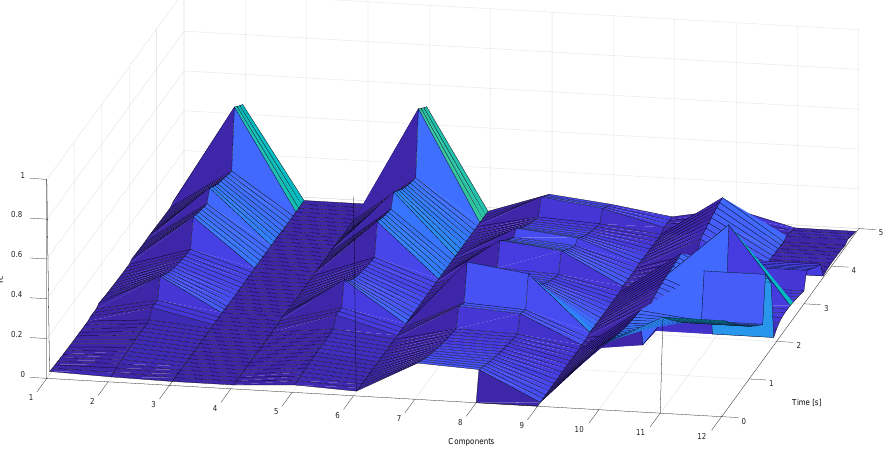
Figure 6. Time-dependent ccriticality: time in seconds.